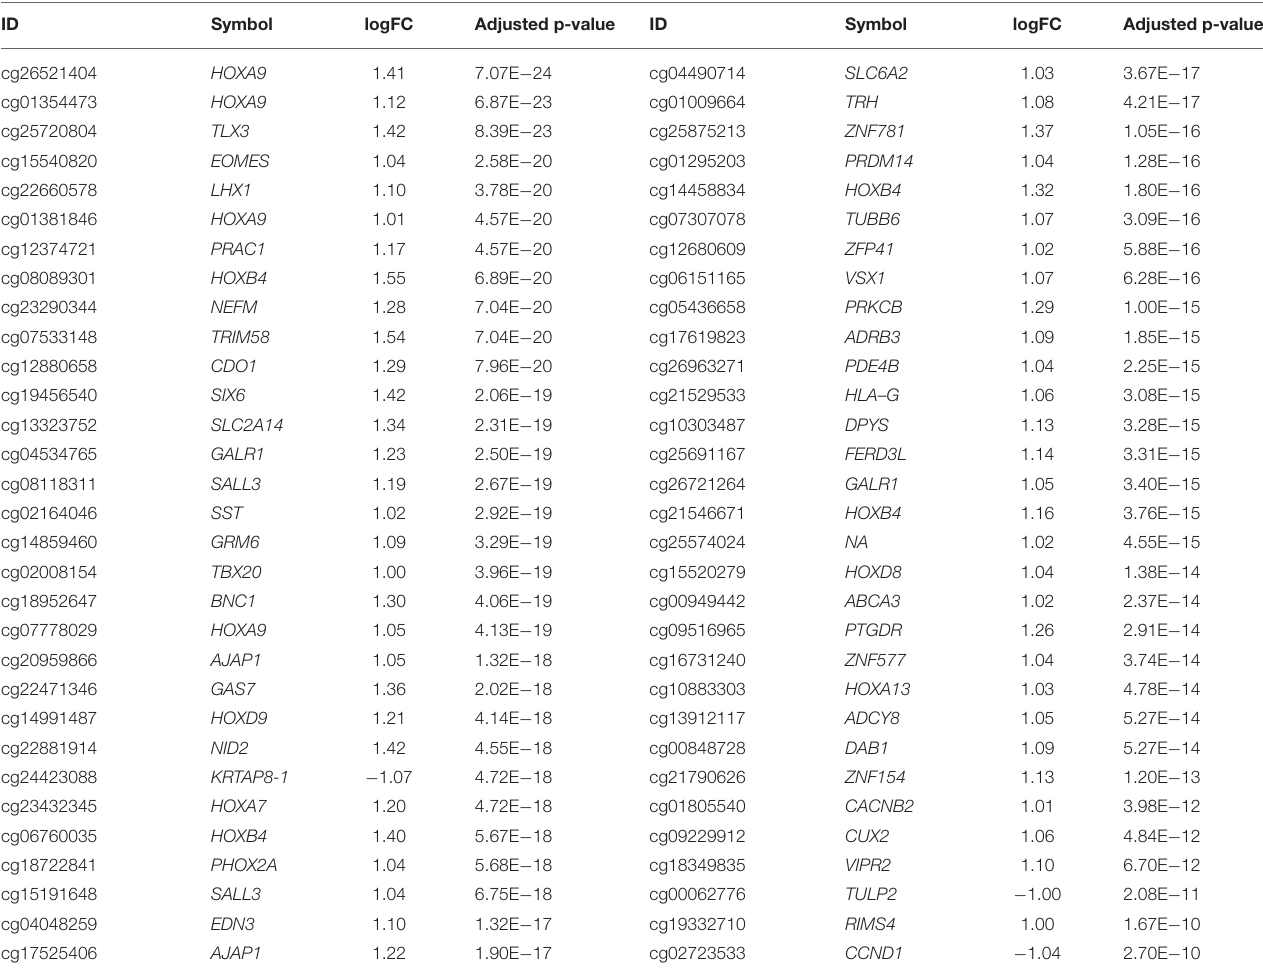
TABLE 2 | Differentially methylated probes detected in the Gene Expression Omnibus (GEO) datasets.